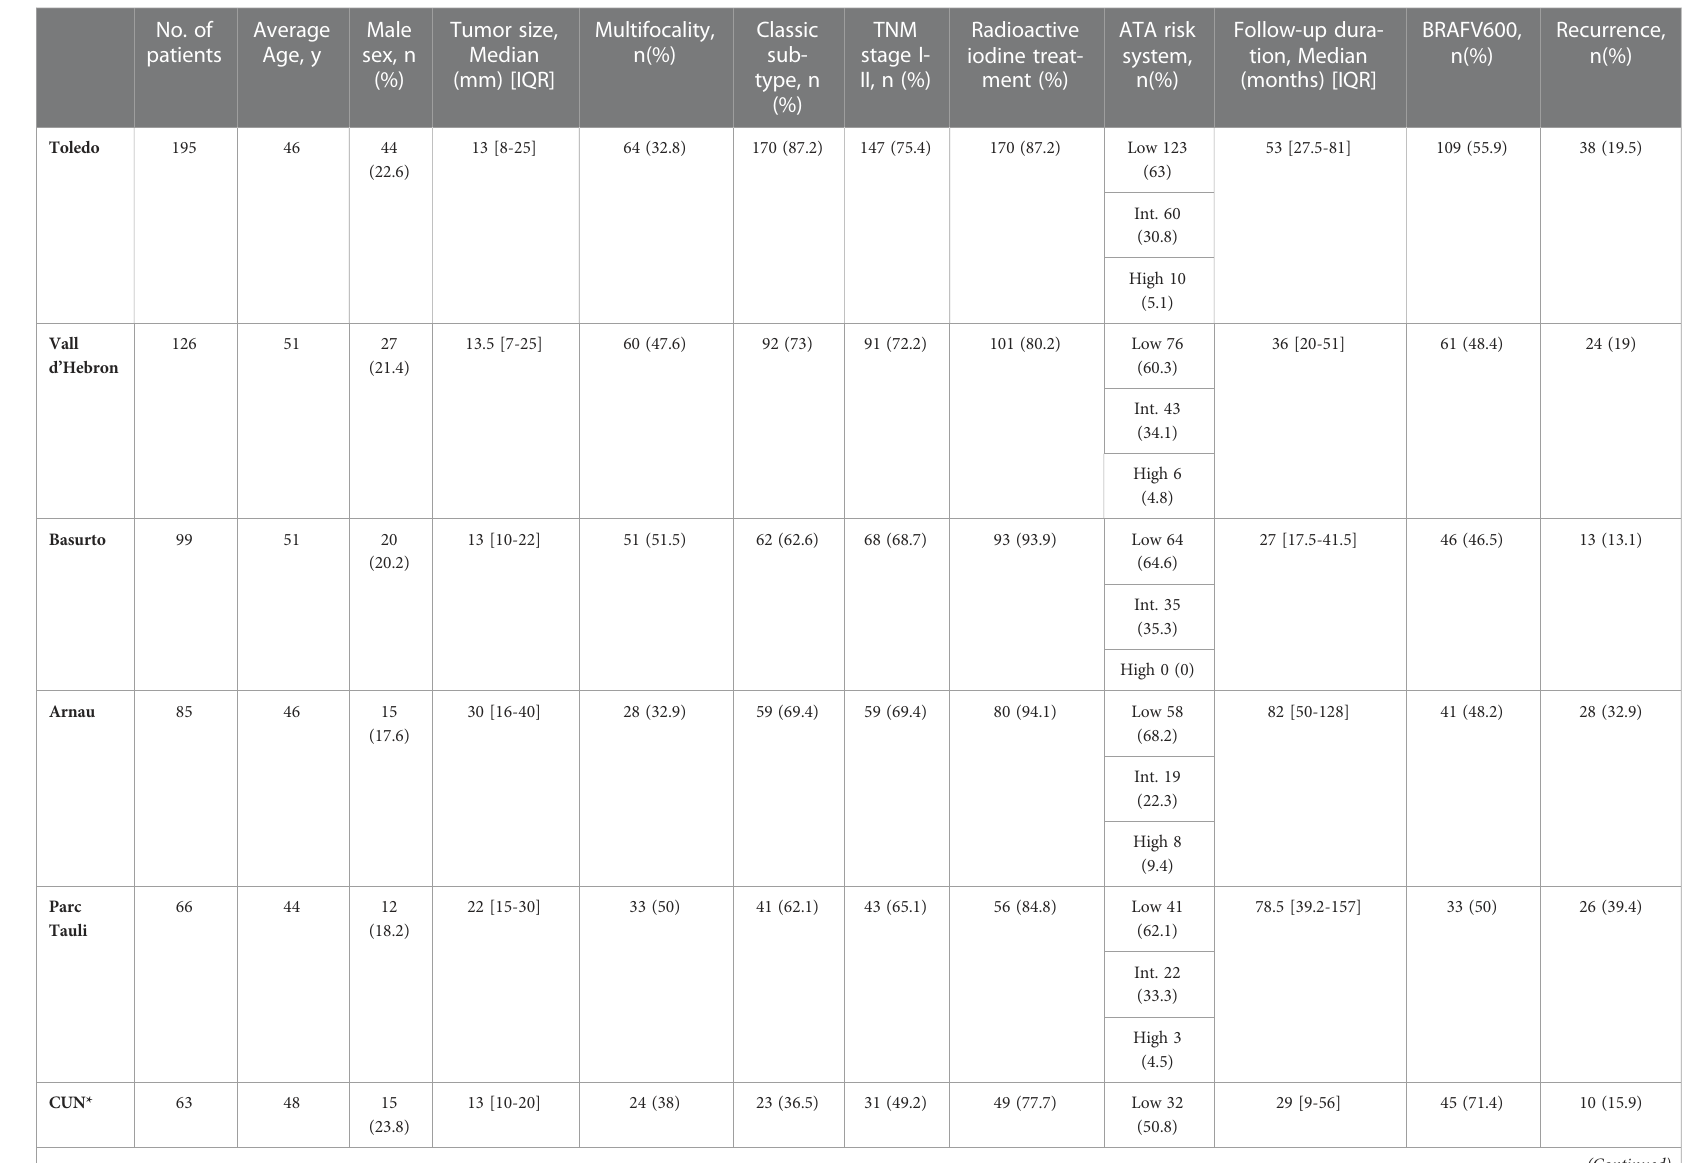
TABLE 1 Characteristics of 685 PTC patients with known postoperative BRAF